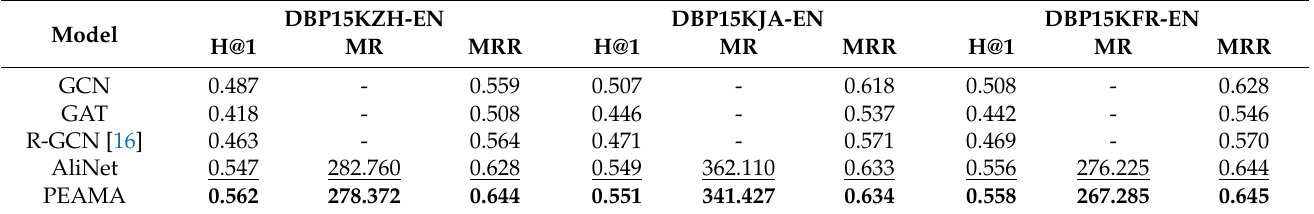
Table 4. Experimental effect of PEAMA on DBP15K and comparison with other entity alignment models. The best results are marked in bold and the second-best results are underlined.